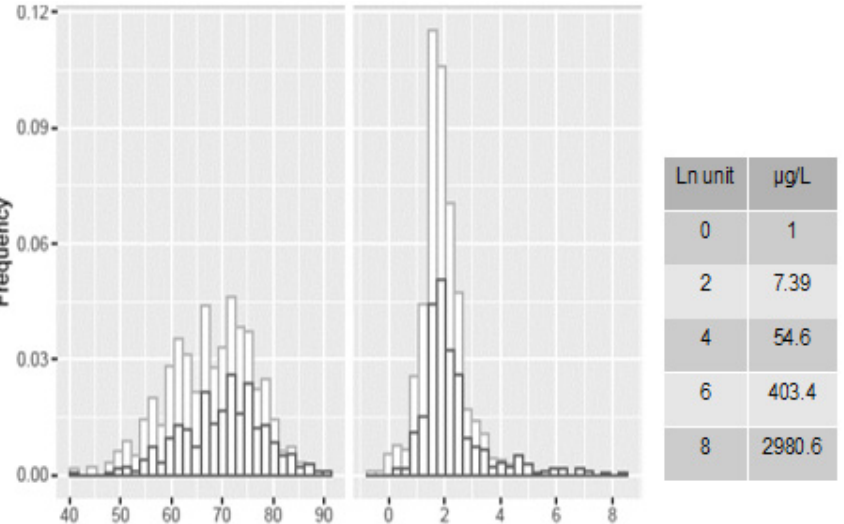
Figure 1. Distribution of age (left) and ln PSA concentrations (right) in patients with (black histograms) and without (grey histograms) prostatic cancer.